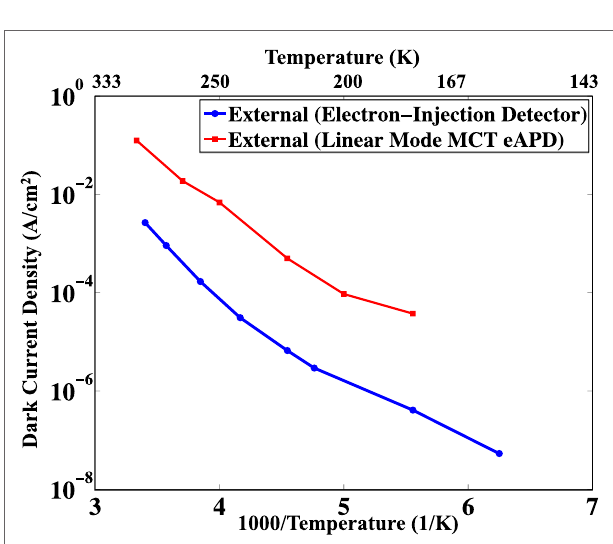
FiGURe 13 | The minimum number of photons that the ei detector can detect (~670 photons) is limited by the electronic noise from the post-detection circuitry amplifier noise (~2600 electrons root mean squared in 10 μ s pulse width) . Performance comparison with other SWIR detector technologies demonstrated that the electron-injection detectors offer more than three orders of magnitude better noise-equivalent sensitivity and Refaat et al.